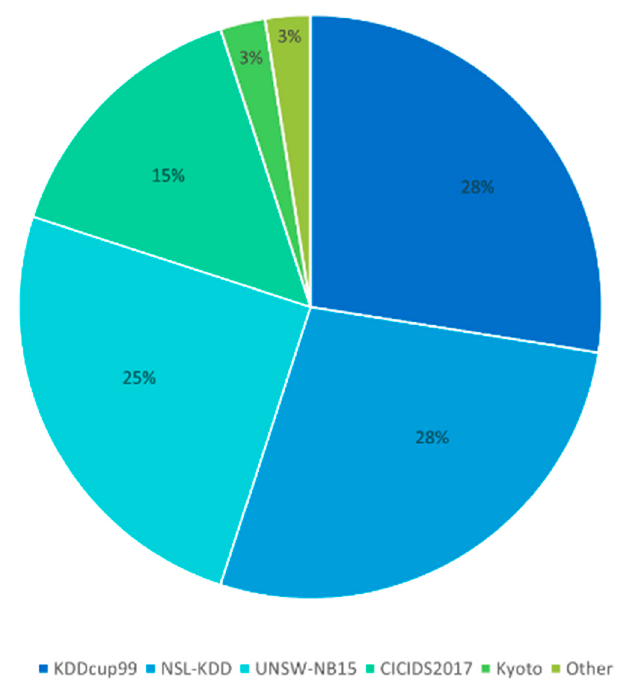
Figure 7. Public datasets percentage of use (Section 6).